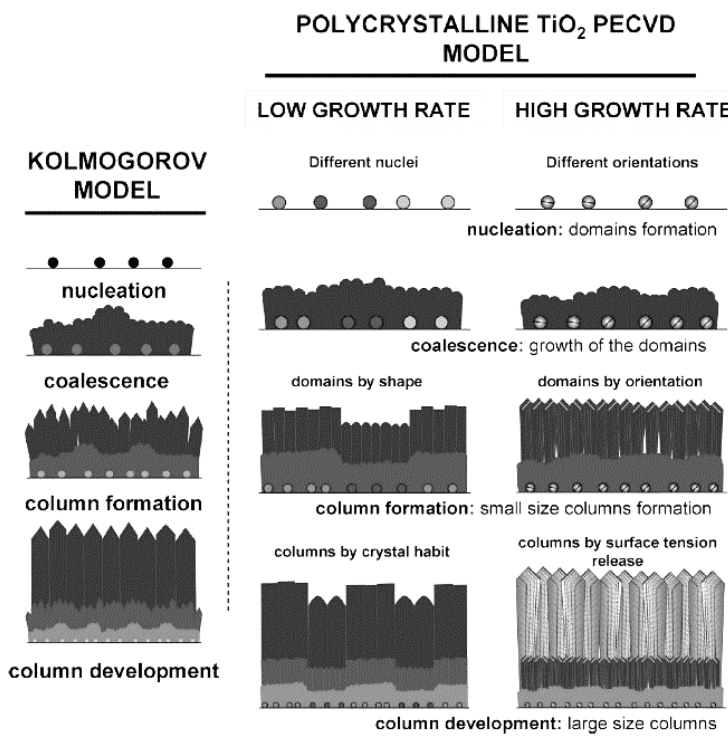
Figure 5. Schematic diagram of a Kolmogorov model (left) and TiO 2 film grown with low and high deposition (growth) rates (right). Reprinted with permission from Ref. [58]. Copyright (2009) American Chemical Society.